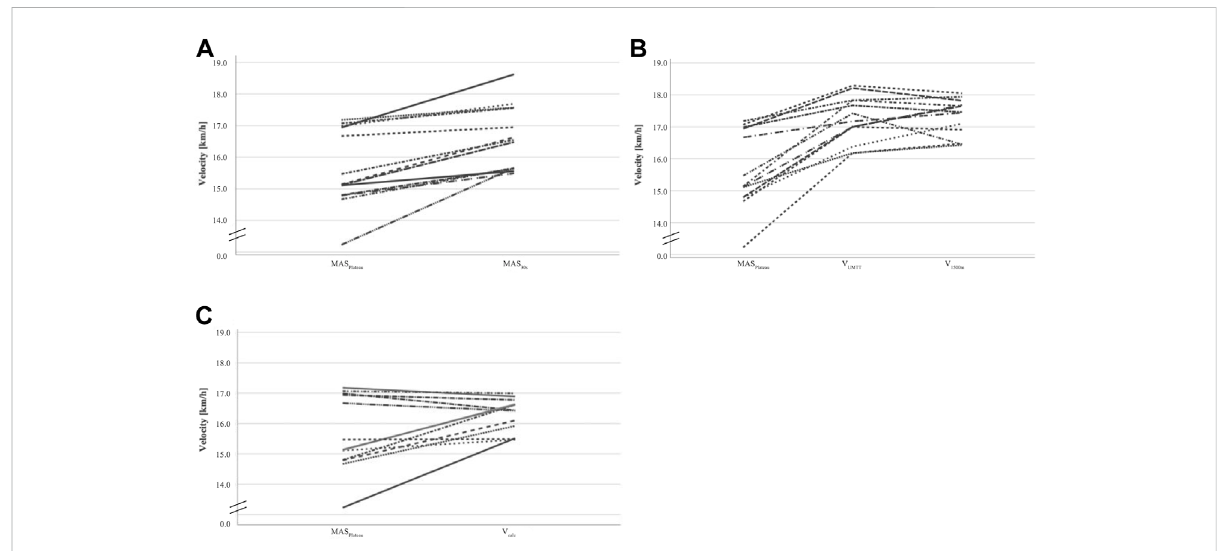
FIGURE 1 Spaghetti plots for intra- and interindividual comparison of (A) MAS Plateau and MAS 30s ; (B) MAS Plateau , V UMTT , and V 1500m ; and (C) MAS Plateau and V calc .